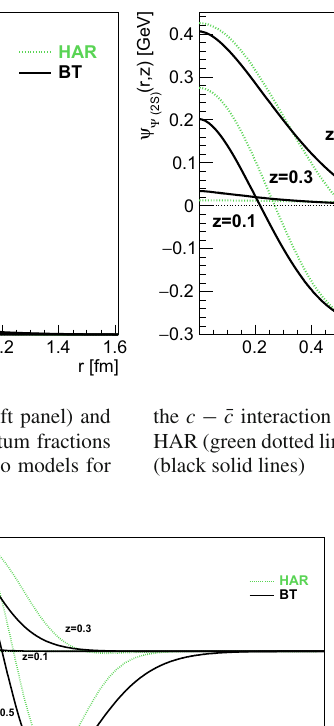
by two models for the b − ¯ b interaction potential: harmonic oscilla- tor model denoted as HAR (green dotted lines) and Buchmüller-Tye parameterisation, or BT (black solid lines)